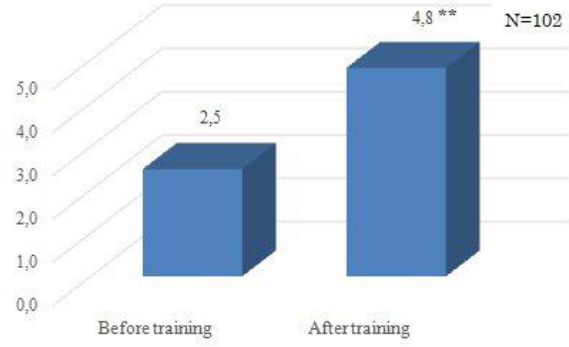
Figure 2: Skills for the prevention of dementia. Paired p-test, ** significant at 1%